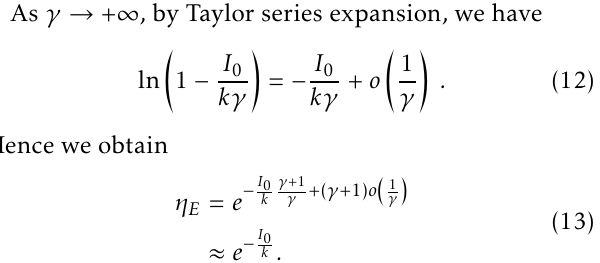
0 = 0 . 1 , 0 . 2 , 0 . 5 , 0 . 7 , 0 . 8